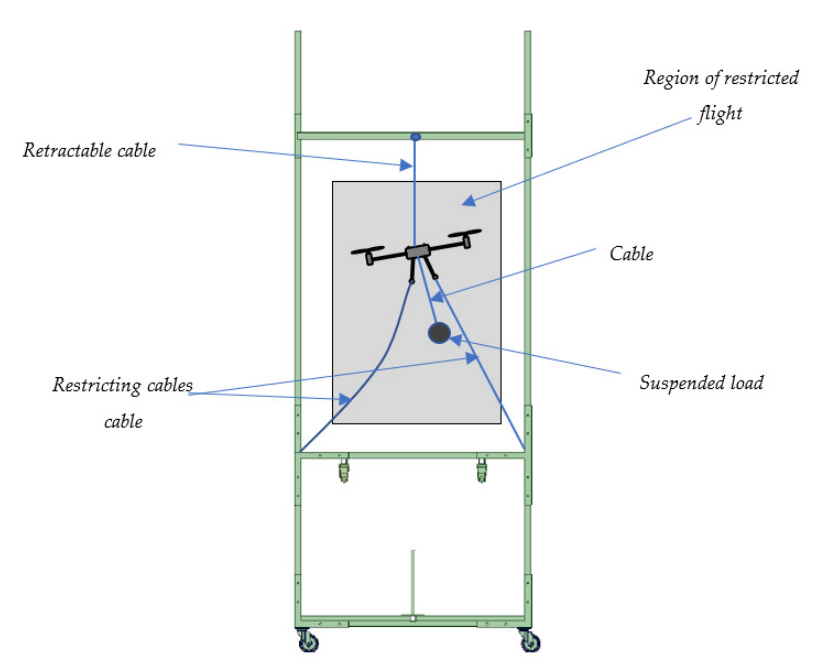
Figure 2. Region in the test platform where the flight of the multirotor is restricted.